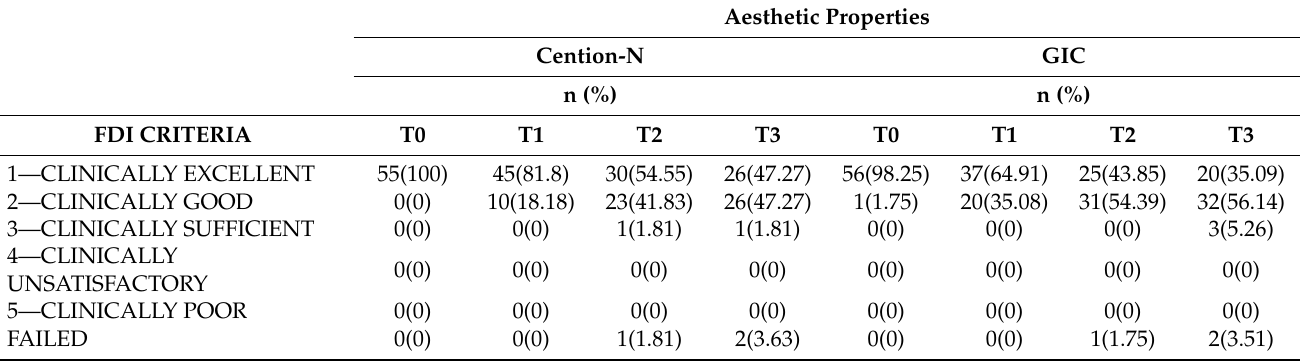
Table 3. Evaluation of aesthetic properties based on FDI criteria. T1 (3 months), T2 (6 months), T3 (12